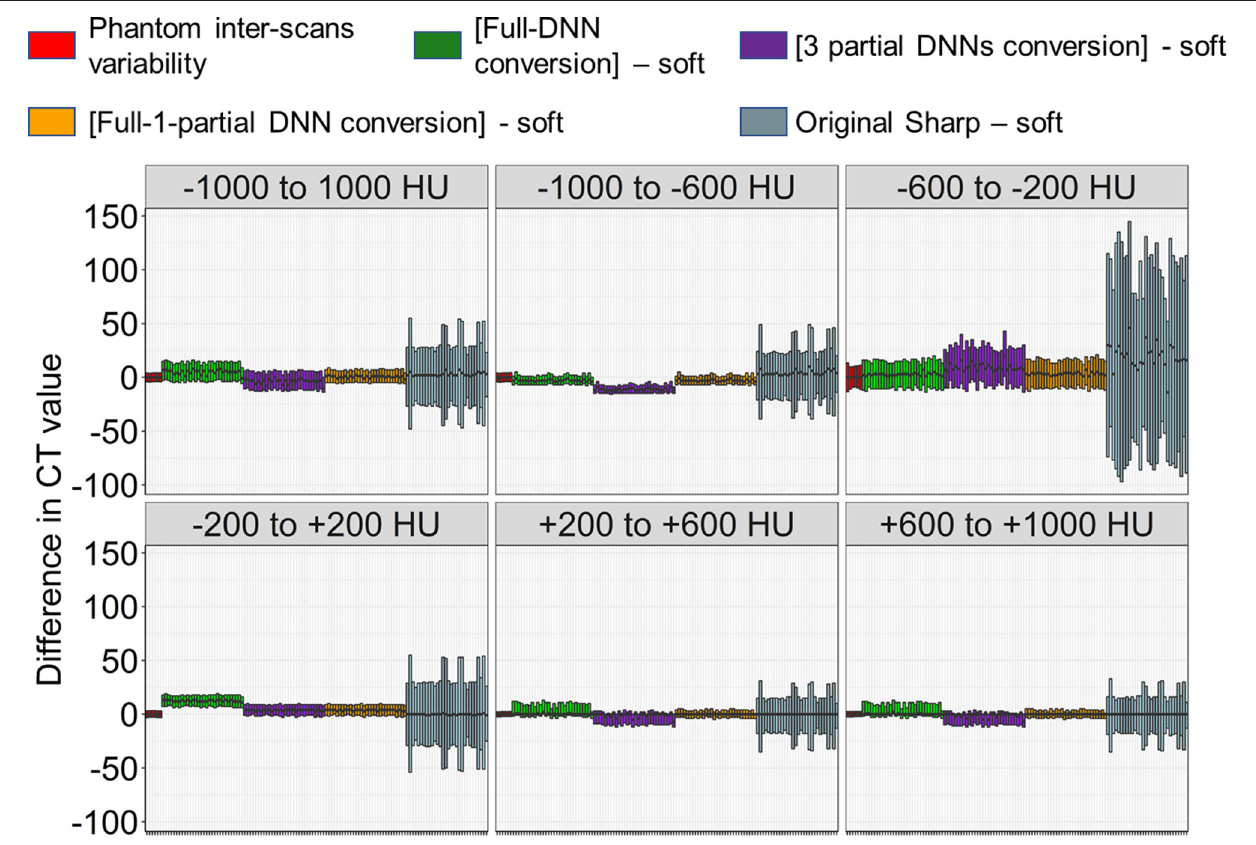
FIGURE 5 | Differences in CT values between images converted using a combination of full and partial deep neural network models and the ground-truth soft kernel images. An inter-scans variability was estimated as differences between the averaged CT values of six repeated scans of the phantom and each of them. Deep neural network (DNN)-based conversion from sharp kernel images in the validation dataset ( n = 30) were performed without truncating CT images for training (Full-DNN conversion) and with truncating the CT values to a given range such as − 300 to 300 HU (partial DNN). Full-1-partial DNN conversion indicates a combination of images converted with the full DNN and images converted with a partial DNN with truncation of CT values to − 300 to 300 HU. Additionally, 3 partial DNN conversions were performed by combining partial DNN with truncation of CT values to − 2,048 to 0, − 300 to 300, and 0 to 1,500 HU. The differences in CT values between each converted images and ground-truth soft-kernel images were compared to the phantom-derived inter-scans